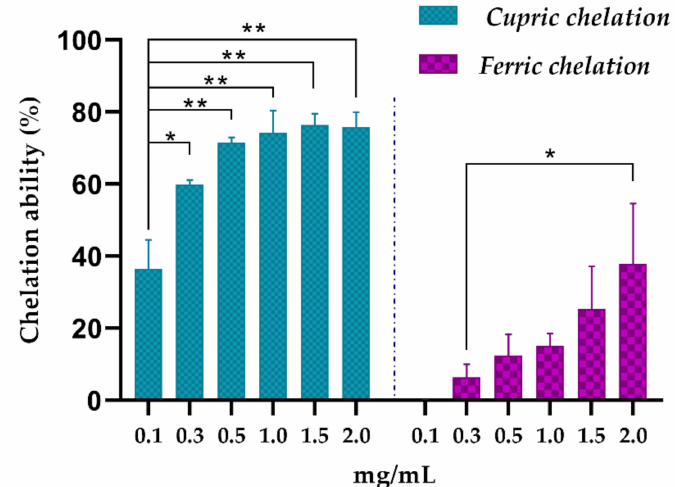
Figure 3. Metal chelating capacity of A. sisalana agro-industrial residue extract. Cupric and ferric chelating activity. * p < 0.05 and ** p < 0.01 by one-way ANOVA. The assay was carried out in three independent experiments, performed in triplicate. The results were expressed as mean ± DP. For cupric chelating, the positive control used (EDTA) reached maximum inhibition from the concentration at 0.03 µ g. For ferric chelating, the positive control used (EDTA) reached maximum inhibition from the concentration at 5.0 µ